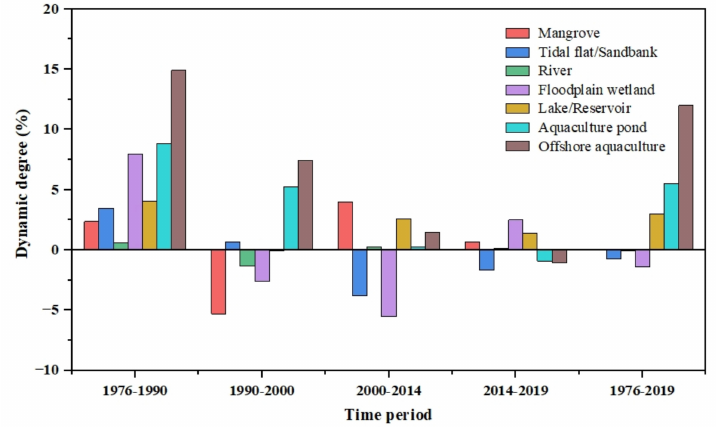
Figure 4. Dynamic degree of each wetland in the study area at each time